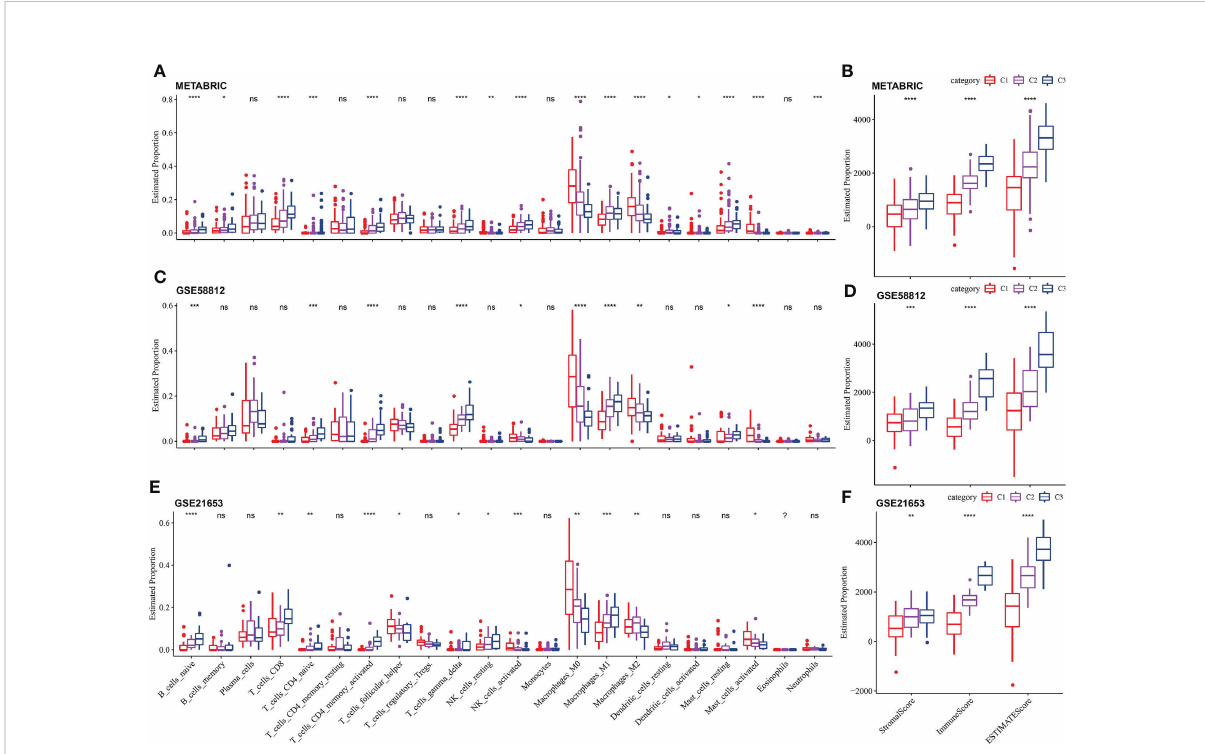
FIGURE 5 Immune cell in fi ltration and immune score among the LR pairs-based molecular subtypes. (A) The estimated proportion of 22 immune cells among the LR pairs-based molecular subtypes in METABRIC (A) , GSE58812 (C) , GSE21653 (E) cohort. The comparison of stromal score and immune score and ESTIMATE score among three LR pairs-based molecular subtypes in METABRIC (B) , GSE58812 (D) and GSE21653 (F) cohorts calculated by ESTIMATE. P value is calculated by Kruskal-Wallis test, the asterisks represented the statistical p value, ns(no signi fi cance), p>0.05, *p < 0.05, **p < 0.01, ***p < 0.001, ****p <